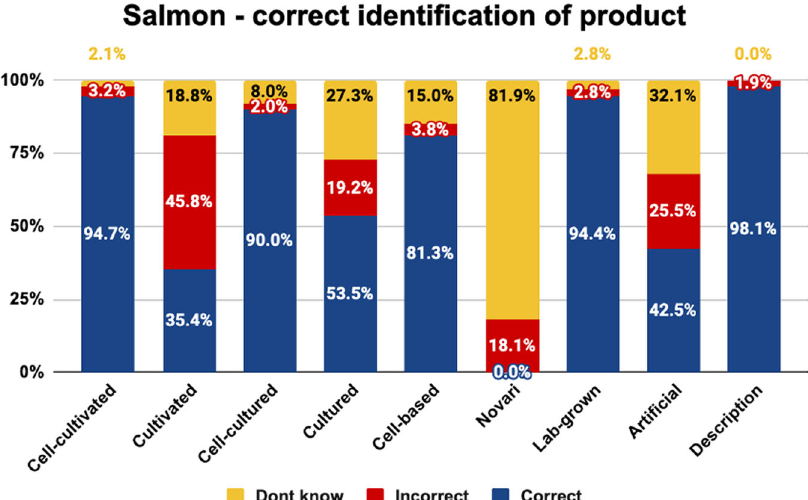
Fig. 3 Correct identi fi cation of salmon by label. The graph shows the proportion of respondents who selected the correct or incorrect cell- cultivated salmon product description, or did not know, by experimental